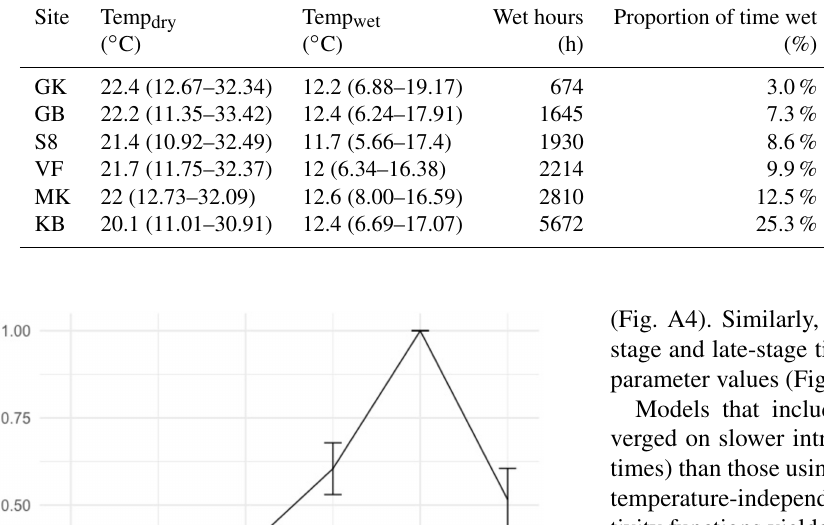
Table 3. Summary of meteorological conditions at each site during the study showing mean temperature when dry, mean temperature when wet, wet hours during the entire study period (as determined by leaf wetness sensors), the proportion of total time when conditions were wet, accumulated rainfall during the study period, and mean relative humidity throughout the study period. Temperature ranges in parentheses report the middle 95% of data. Mean temperatures apply to the time period used in this study but should not be used to infer mean annual temperatures for each site since the study lasted 2.5 years and therefore data from January–August are represented more than September– December. Full names for sites are included in Fig. A1.